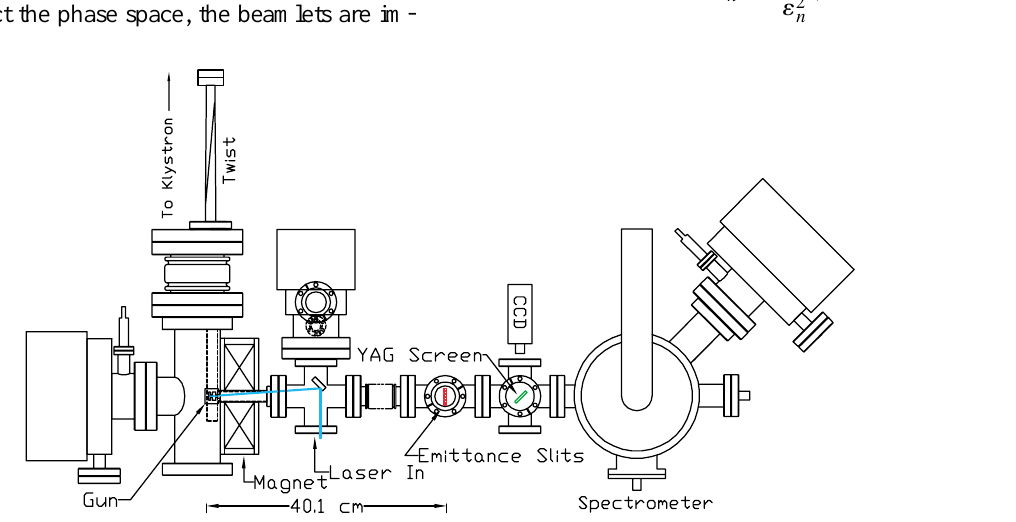
FIG. 4. (Color) Schematic of the RF gun beam